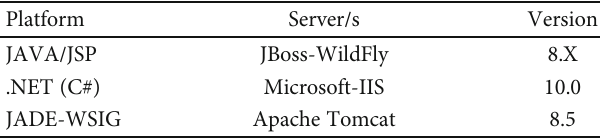
Table 1: Server con fi